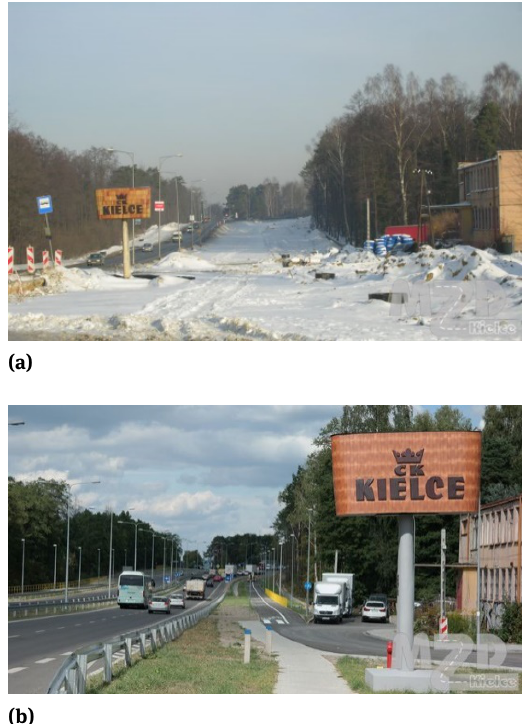
Figure 1: Street view a) in 2013, before reconstruction, b) in 2014, after reconstruction (photos courtesy of MZD